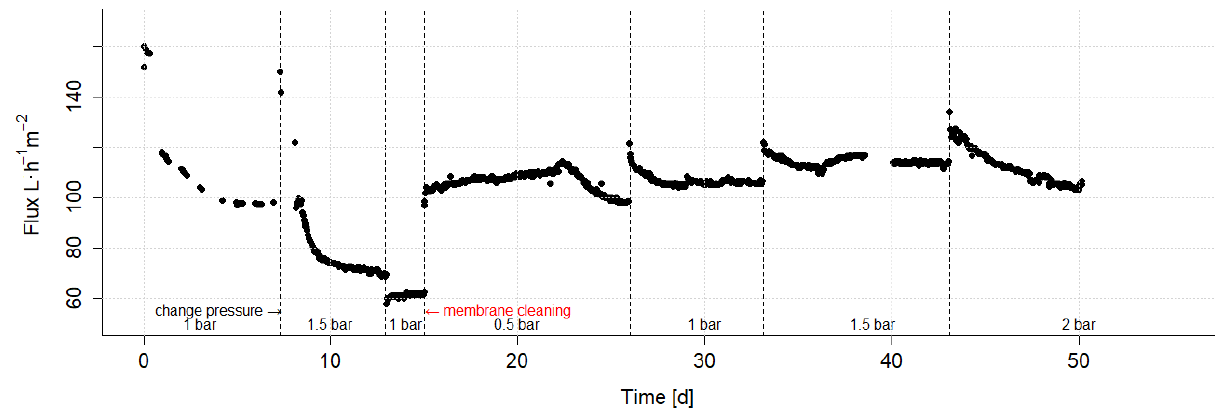
Figure 6. Long-term ultrafiltration experiment: Flux in dependence of transmembrane pressure at a constant cross-flow velocity of 4 m · s − 1 .